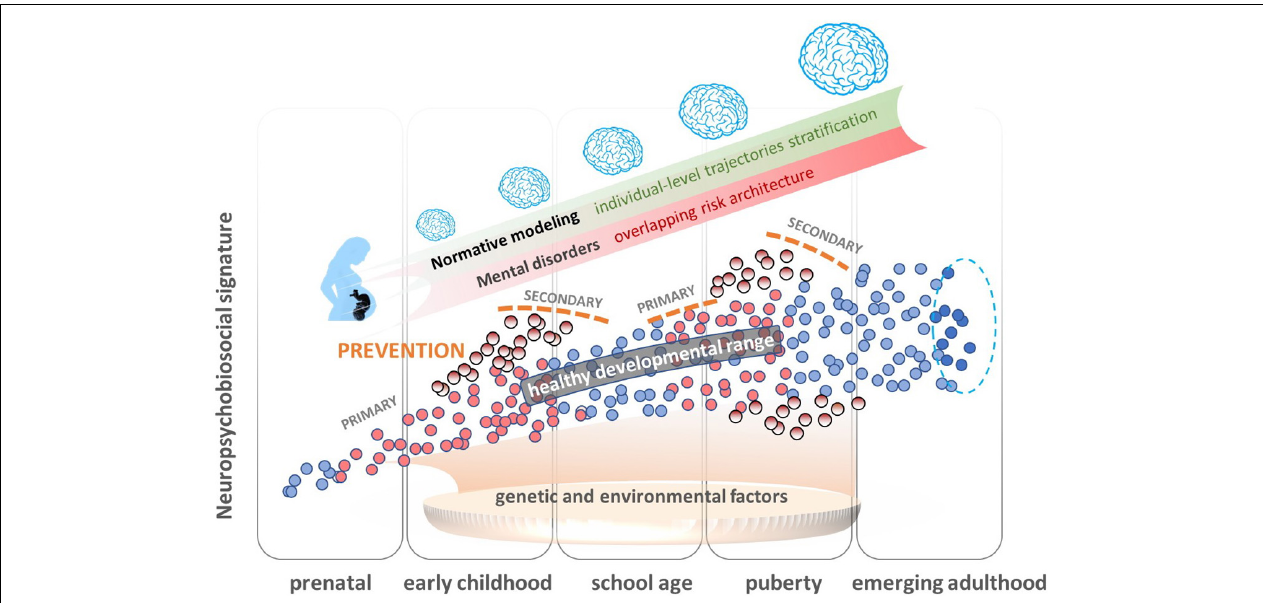
FIGURE 2 | Overview of the normative modeling approach as an innovative analytical framework for parsing underlying biological heterogeneity within epidemiological cohorts without dichotomizing into cases and controls. This approach uses probabilistic regression methods, machine learning, and artificial intelligence (AI) methods to characterize variation across the population, estimate normative models of development (e.g., brain development) during critical phases of vulnerability, and detect individual differences in risk signatures in clinical cohorts. These models therefore enable predictions at an individual subject level within the population, to explore how these signatures predispose individuals to somatic and mental health outcomes, such as failure to thrive, motor, and language delay, behavioral and emotional disorders, and inferences on how deviation patterns map onto biological underpinnings informing primary and secondary prevention (early intervention) approaches. Dots represent individual neuropsychobiosocial signatures. Blue dots represent individuals who stay in the normal range throughout development, and red are those individuals who are in the normal range at a specific developmental time, but move then out of this range (pale red